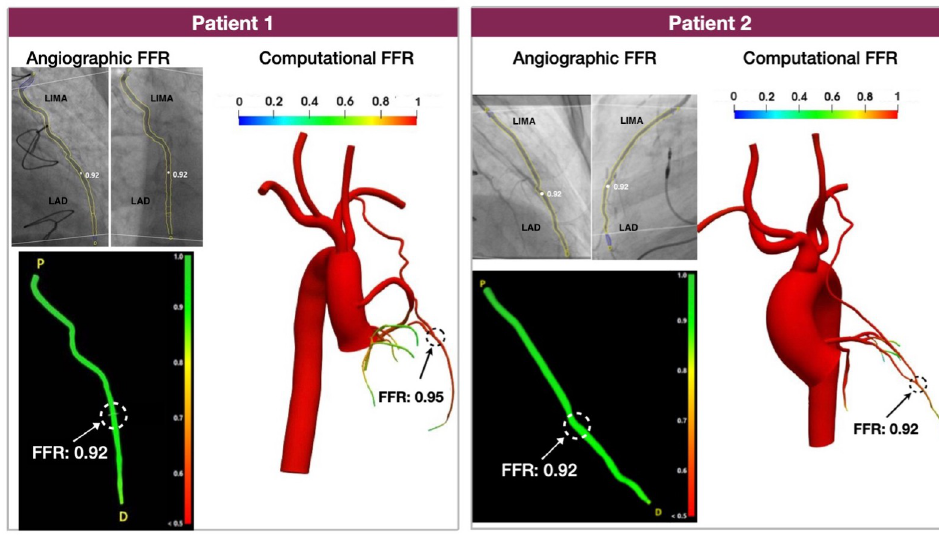
Fig 4. Comparison of the computationally calculated FFR against angiographic FFR in Aim 1 patients. Note the high agreement between computational and angiographic FFR. (FFR: fractional flow reserve).